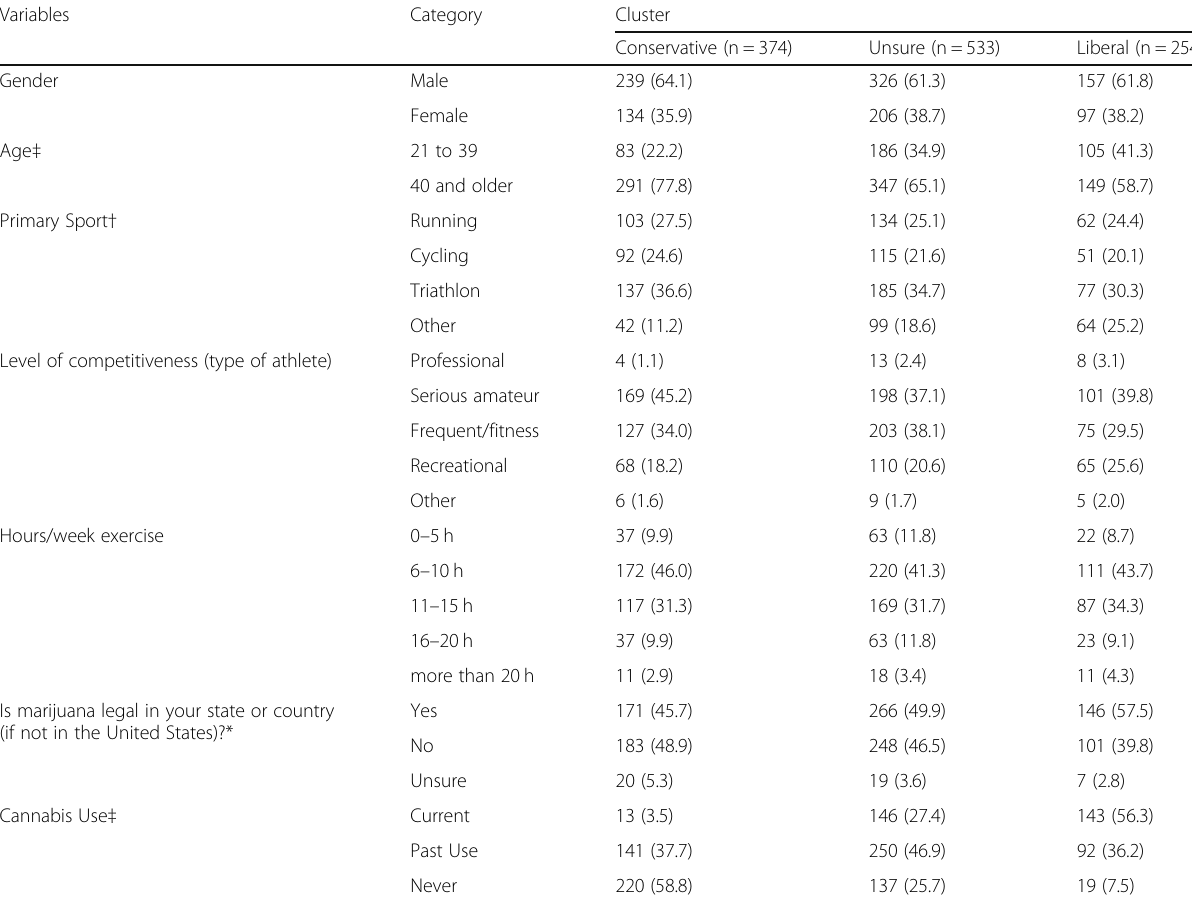
Table 4 Cannabis use attitudes clusters and demographics in adult athletes [Data as N (%)]